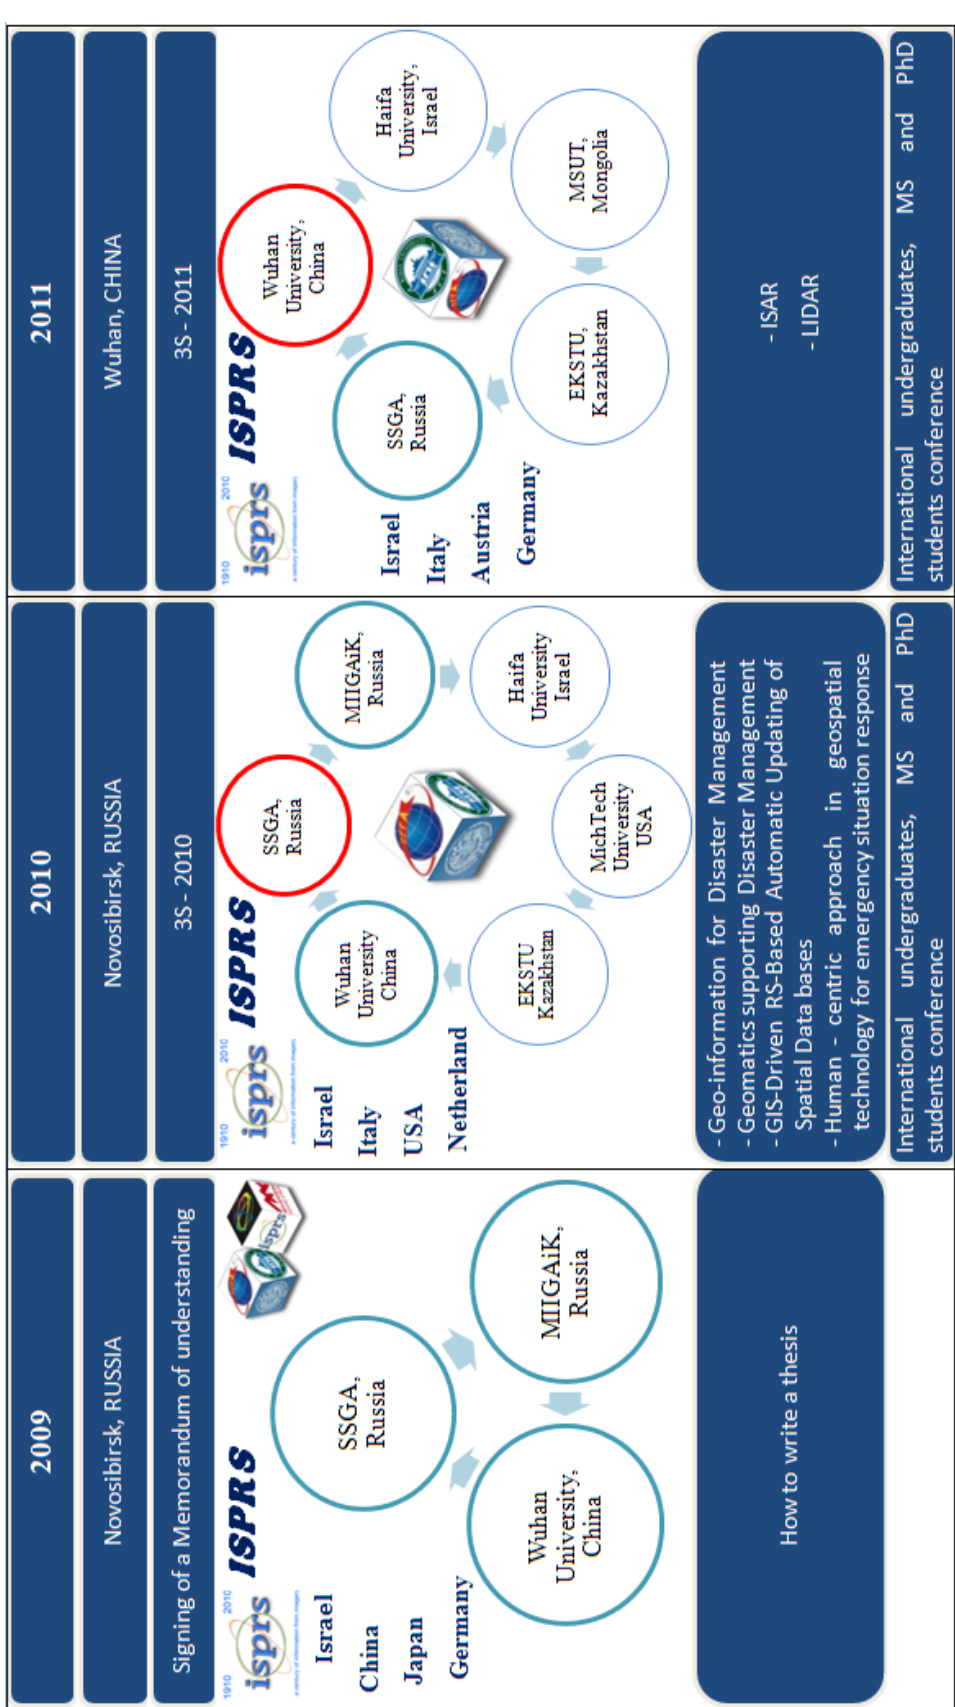
Figure 3. 3S historiography